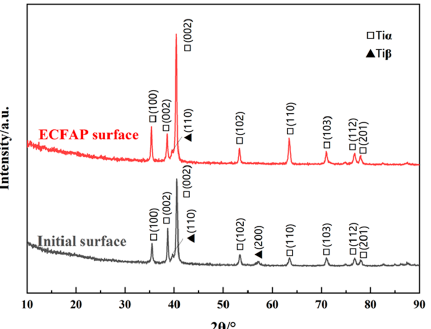
Figure 17. XRD patterns of the initial surface and after ECFAP treatment.